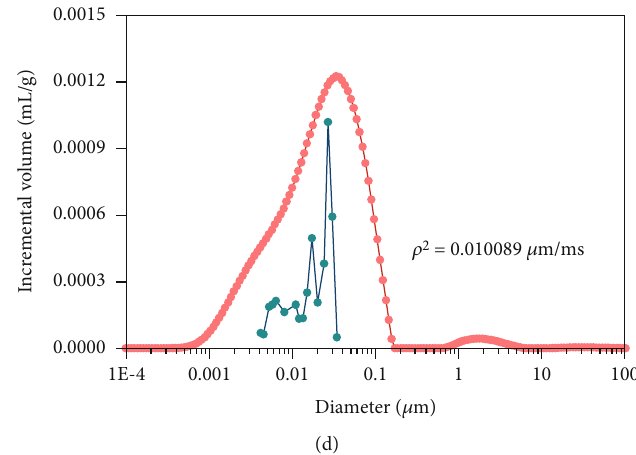
Figure 7: Comparisons of PSD measured by NMR and NMR